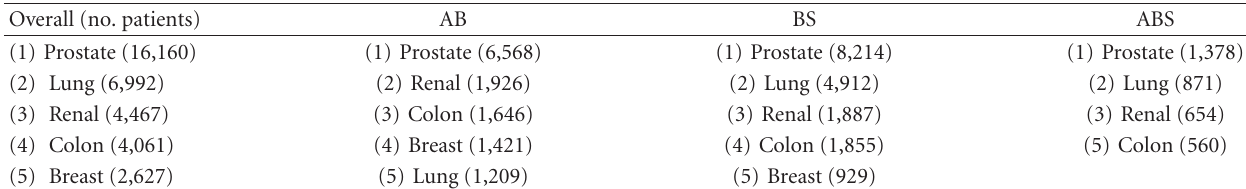
Table 6: Most common nonbladder cancer diagnoses.